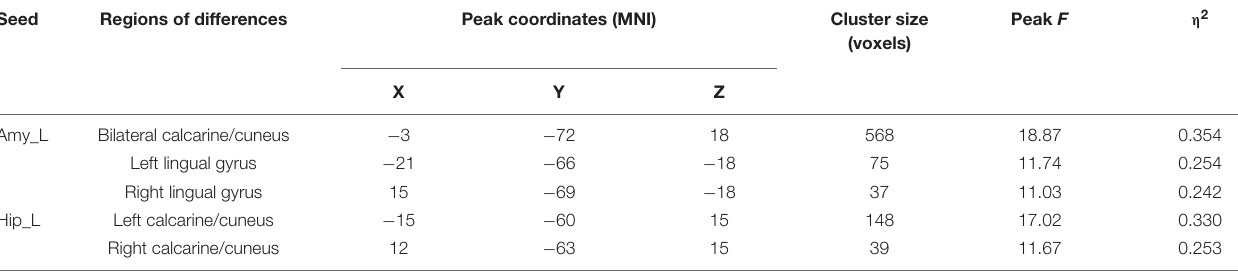
TABLE 2 | Brain regions showing significant differences in rsFC among the HC, migraine and TTH groups.